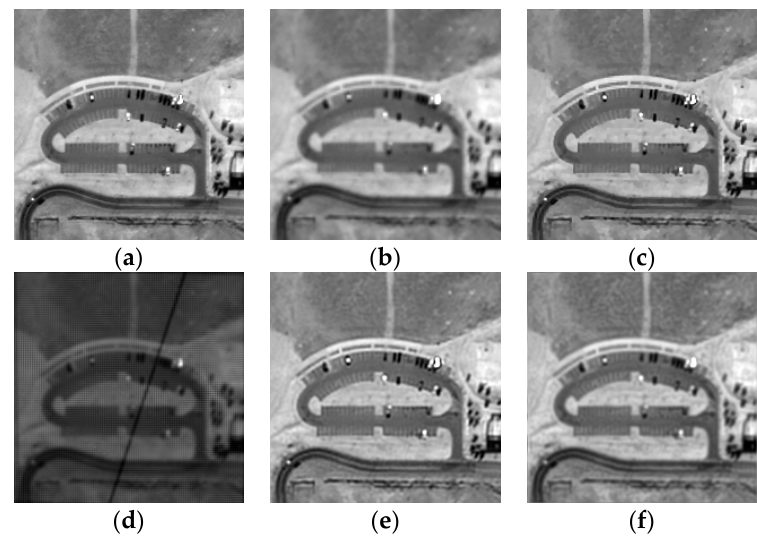
Figure 2. Simulation results of different methods. ( a ) Origin HR image; ( b ) the bicubic upsampled